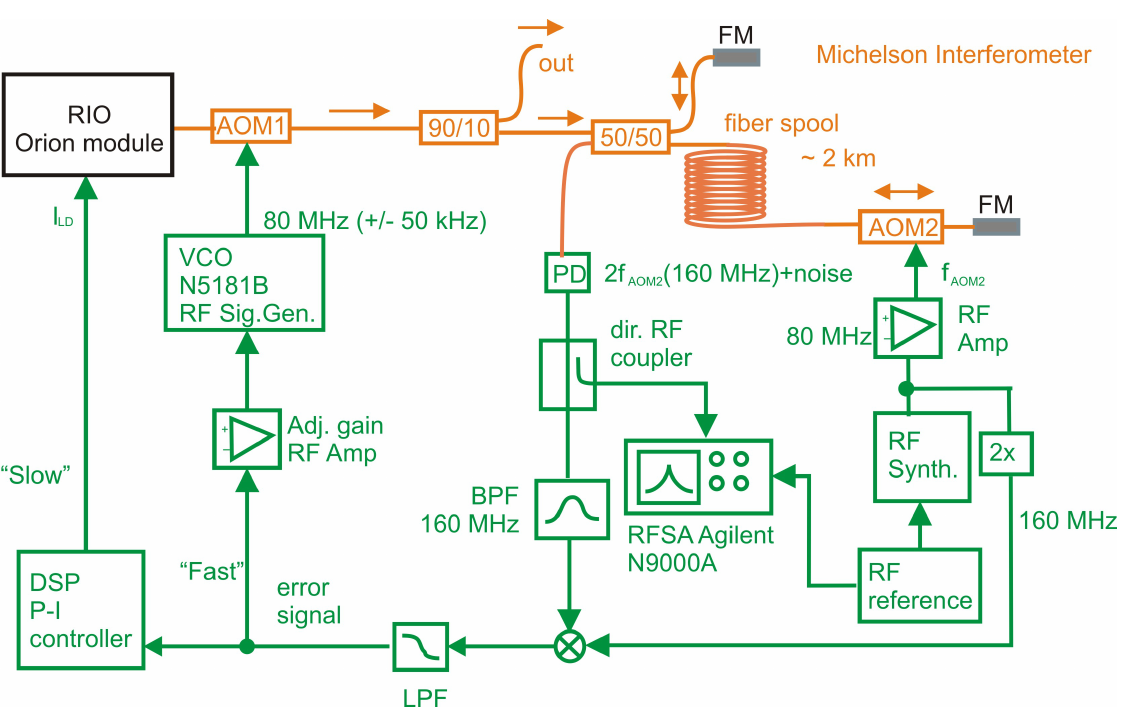
Figure 1. Scheme of the unbalanced interferometer for frequency stabilization: RIO (Redfern Integrated Optics) ORION TM module; laser module, 90/10 and 50/50 fiber splitters; FM, Faraday mirror; AOM1, AOM2, acousto-optic modulators; VCO, voltage control oscillator; PD, photodetector; DSP, digital signal processor; LPF, low-pass filter; BPF, band-pass filter; RFSA, RF signal